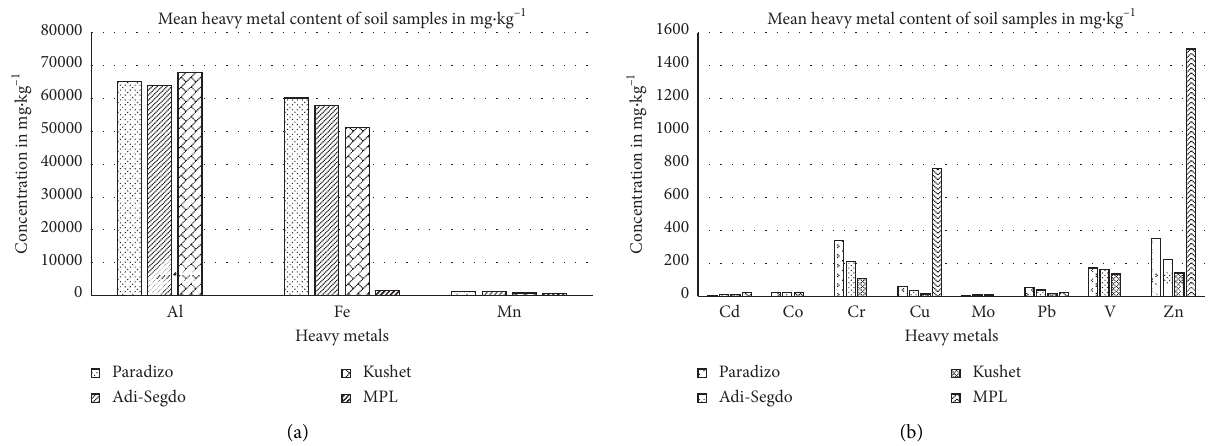
Figure 1: (a) Mean concentration Al, Fe, and Mn in soils from Paradizo, Adi-Segdo, and Kushet. (b) Mean concentration of Cd, Co, Cr, Cu, Mo, Pb, V, and Zn in soils from Paradizo, Adi-Segdo, and